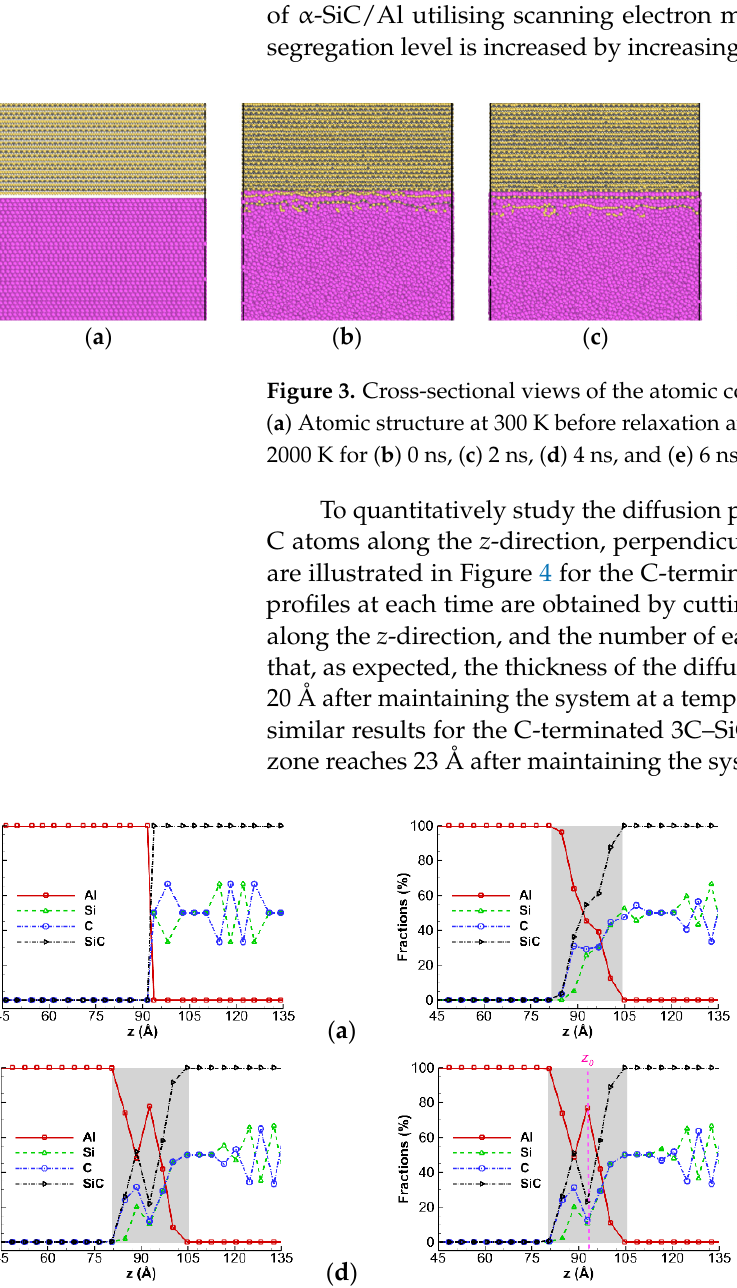
Figure 2. Cross-sectional views of the atomic configurations of C-terminated 6H–SiC/Al interface. ( a ) Atomic structure at 300 K before relaxation and the configuration after maintaining the system at 2000 K for ( b ) 0 ns, ( c ) 2 ns, ( d ) 4 ns, and ( e ) 6 ns.